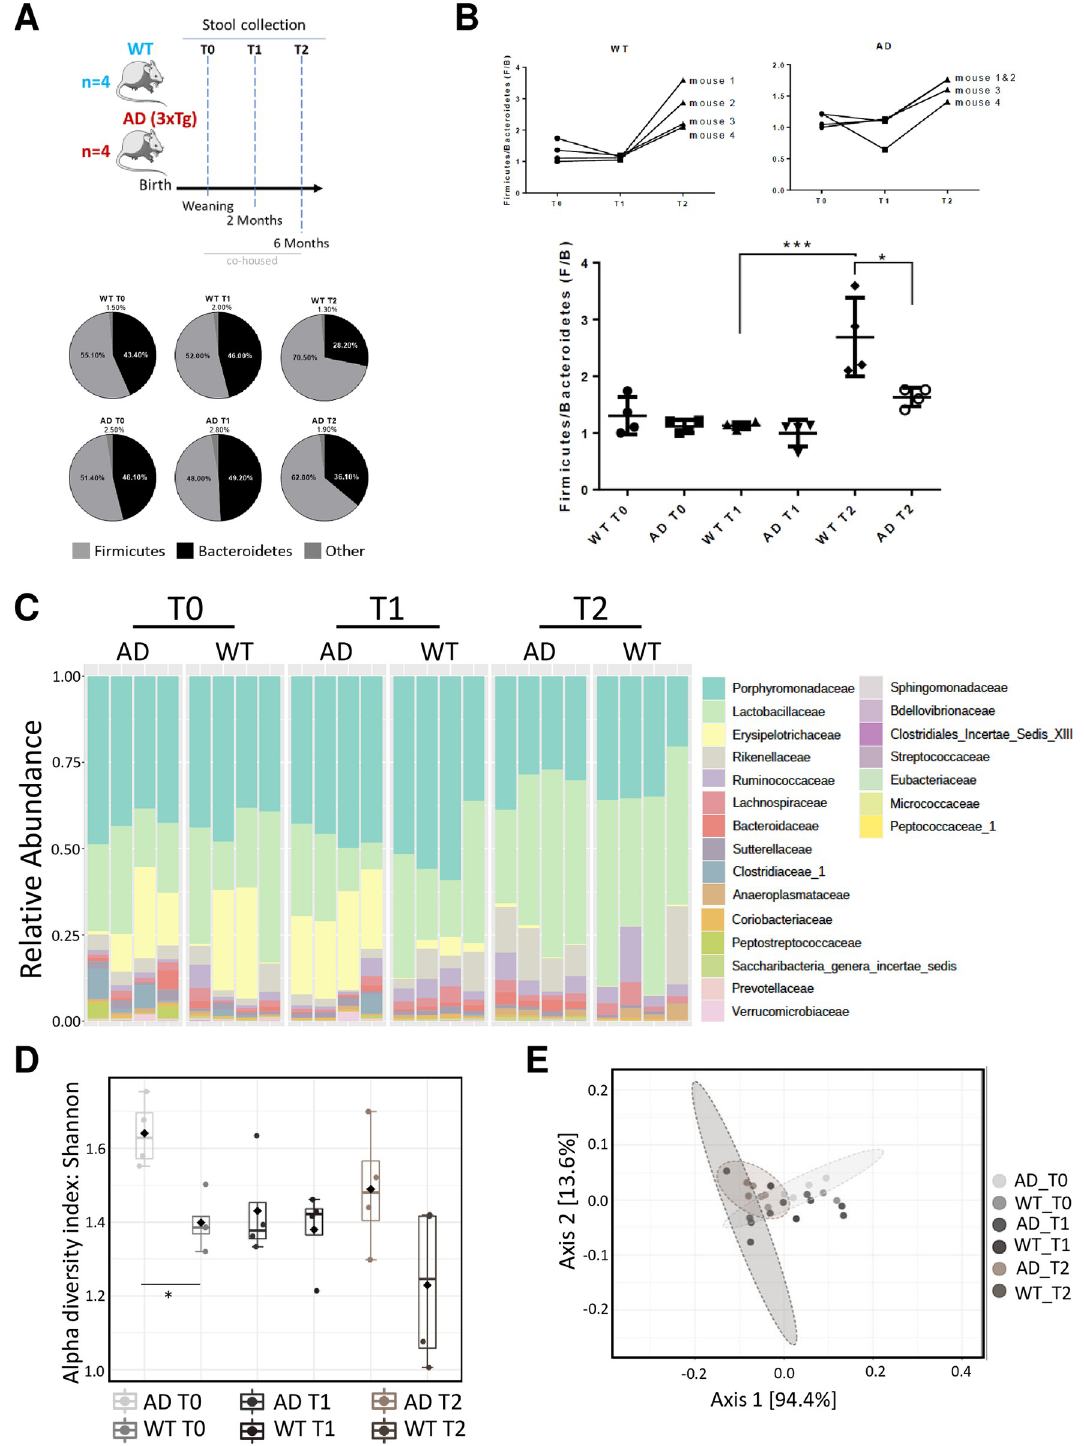
Fig 1. Global 16S metagenomics profiling. A) Schematic representation of study design (upper panel); Abundance profiles of microbes (percentage) in mice stool at the phylum taxonomic rank (bottom panel); samples were named as reported in experimental design. B) The Firmicutes/Bacteroidetes ratio was calculated in each animal at the indicated time point T0, T1 and T2, and plotted individually (upper panels) or grouped (bottom panel). An ANOVA analysis was performed using all groups. � p < 0,05; ��� p < 0,001. It is important to note that a statistical difference was only observed compared WT T1 vs WT T2 groups, and WT T2 vs AD